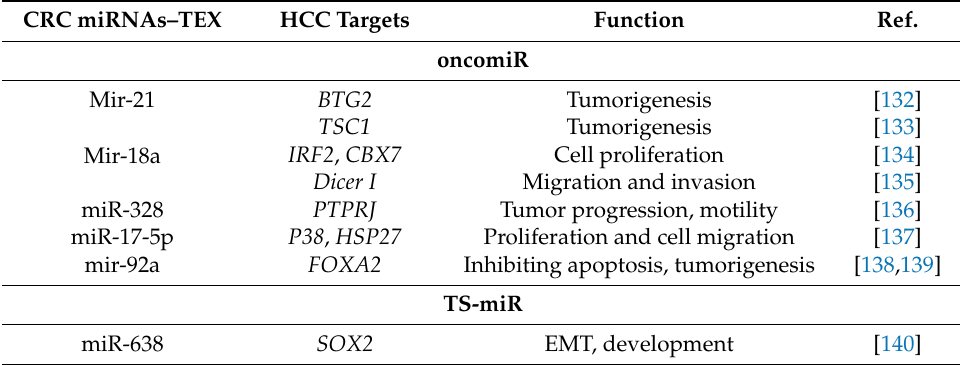
Table 3. Common miRNAs identified both in exosomes-delivered by CRC cells and in the early diagnosis of hepatocellular